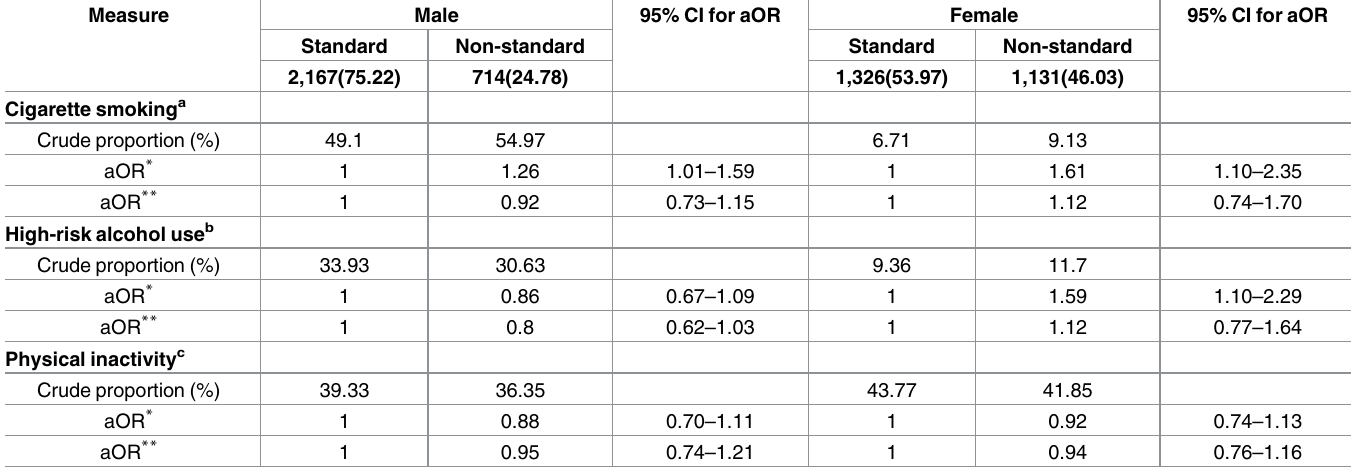
Table 2. Differencesin the cardiovascular health risk behaviors between standard and nonstandard